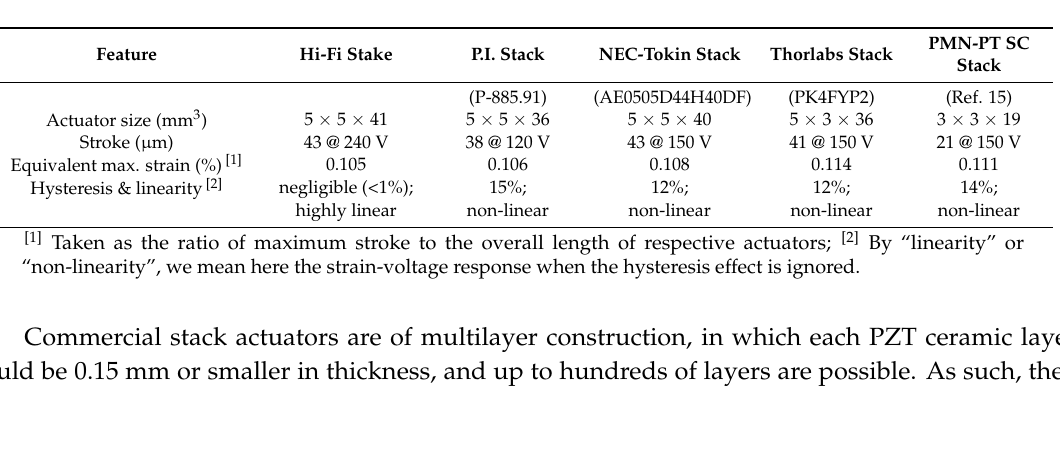
Table 2. Performance comparison of Pb(Zn 1/3 Nb 2/3 )O 3 -PbTiO 3 (PZN-PT) single crystal ‘Hi-Fi stake’ and commercial stack actuators of L = 36–41 mm [12–14] and with Pb(Mg 1/3 Nb 2/3 )O 3 -PbTiO 3 (PMN-PT) single crystal stack [15].